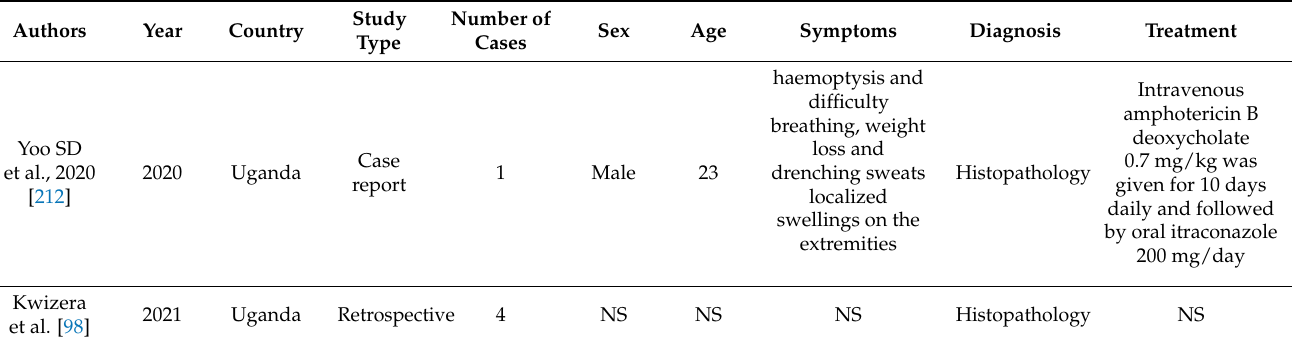
Table 10. Case studies on Coccidioidomycosis published in